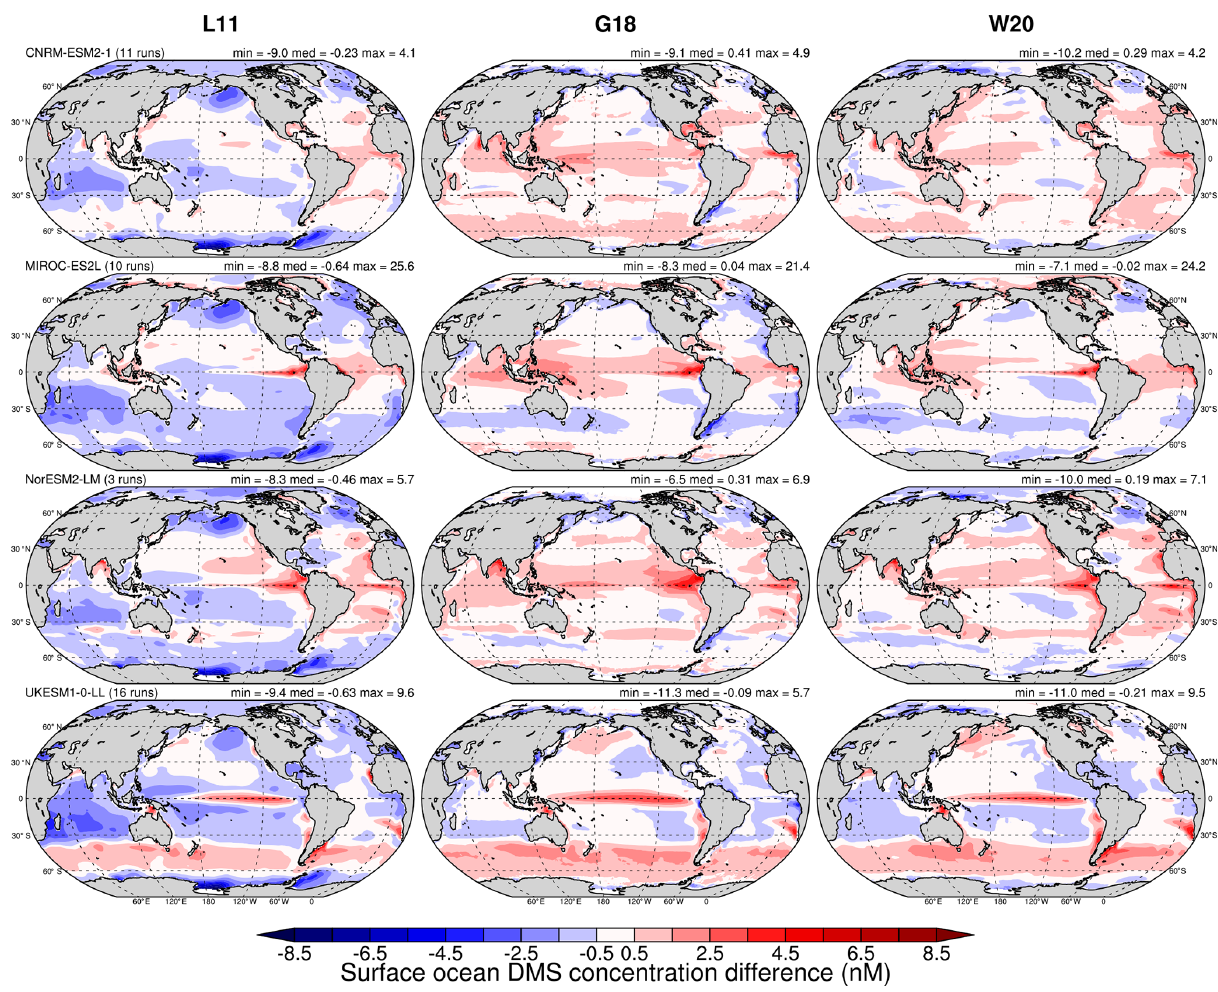
Figure 2. Mean annual differences of surface ocean DMS concentration (nM) between models and the climatologies of L11, G18, and W20 (model minus climatology). Model data are as in Fig. 1. Minimum, weighted median, and maximum of each panel are